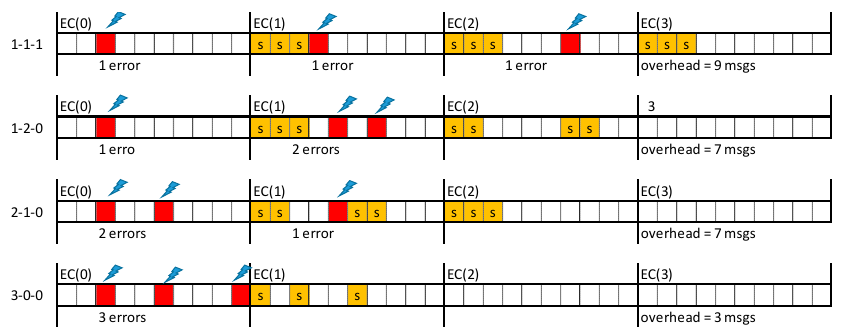
} Figure 7. Possible error sequences in consecutive cycles. After obtaining these two values, we can build the various error sequences or scenarios, Error_S , that produce maximum interference. These are the result of all combinations with length max_cycles and a maximum of max_1cycle errors per EC. For instance, if we consider both max_cycles and max_1cycle equal to 3, then the possible error combinations are the ones presented in Figure 7. The horizontal-axis in Figure 7 represents the ECs, while errors with probability greater than p ε are represented by a solid circle. These sequences, when combined with the RepLevel vector, allow for us to build the set of Interf_P required for computing Equation (16), as explained in the next section . 5.3. Server Interference The error server execution may interfere with any message, having different interference patterns, depending in error sequence and server configuration. We define Indirect Interference on one message when this message does not suffer errors itself, but is delayed by the server executing on behalf of other messages. The Direct Interference corresponds to scenarios where one error affects the message being analyzed. When calculating the response time with direct interference we must also account, at first, with the recovery of n-1 errors (of indirect interference), in a scenario with n errors in total. This aspect is further clarified in Section 5.3.2. The worst-case response time for any message is the maximum of both types of interference. As we will see later on, direct interference is normally more penalizing but it is not always the case, thus the need to compute both scenarios. 5.3.1. Indirect Interference The server execution may delay the dispatching of lower priority messages, thus causing